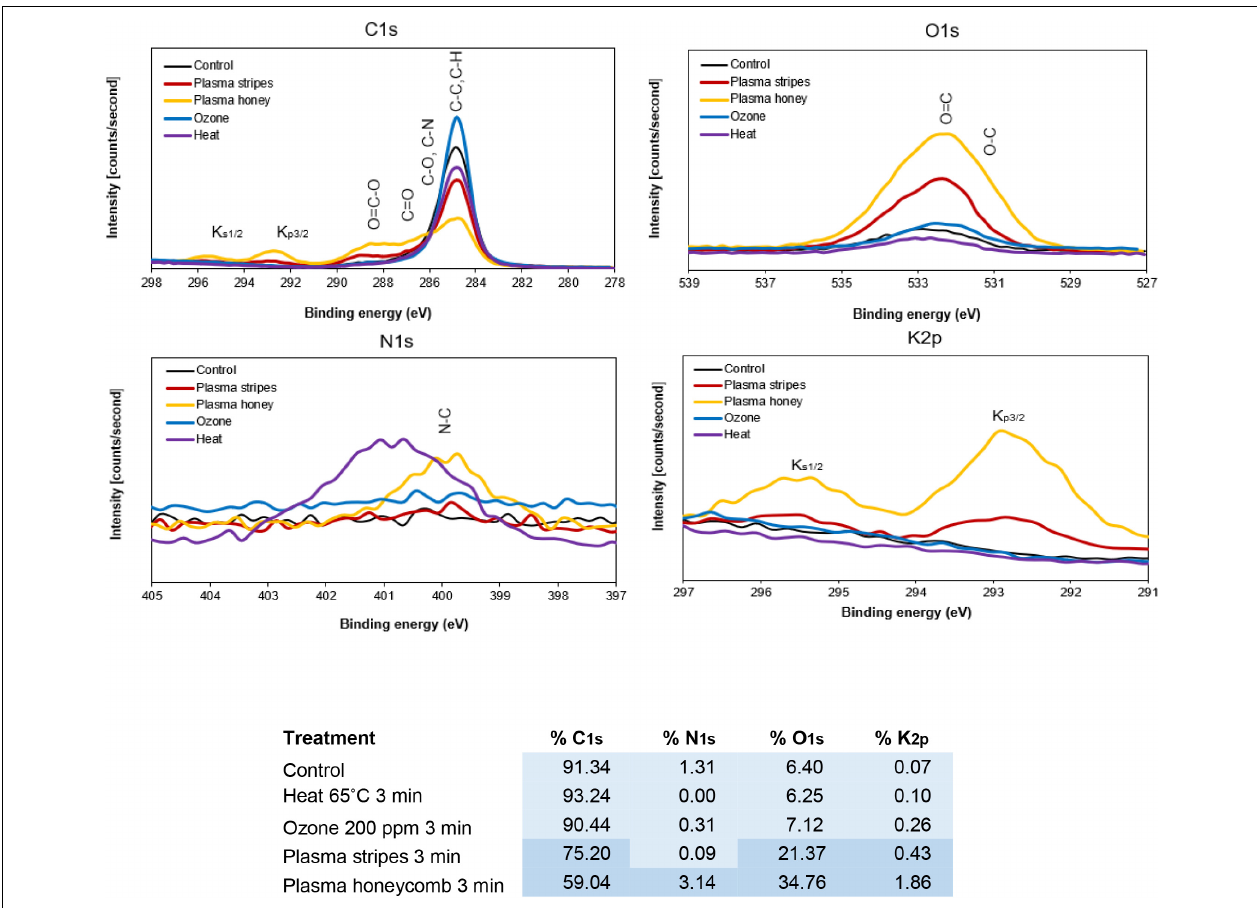
FIGURE 3 | X-ray photoelectron spectroscopy (XPS) spectra with atomic concentration table of carbon, nitrogen, oxygen, and potassium in untreated, heat-treated, ozone-treated, and plasma-treated (stripe and honeycomb electrodes) Arabidopsis seeds.